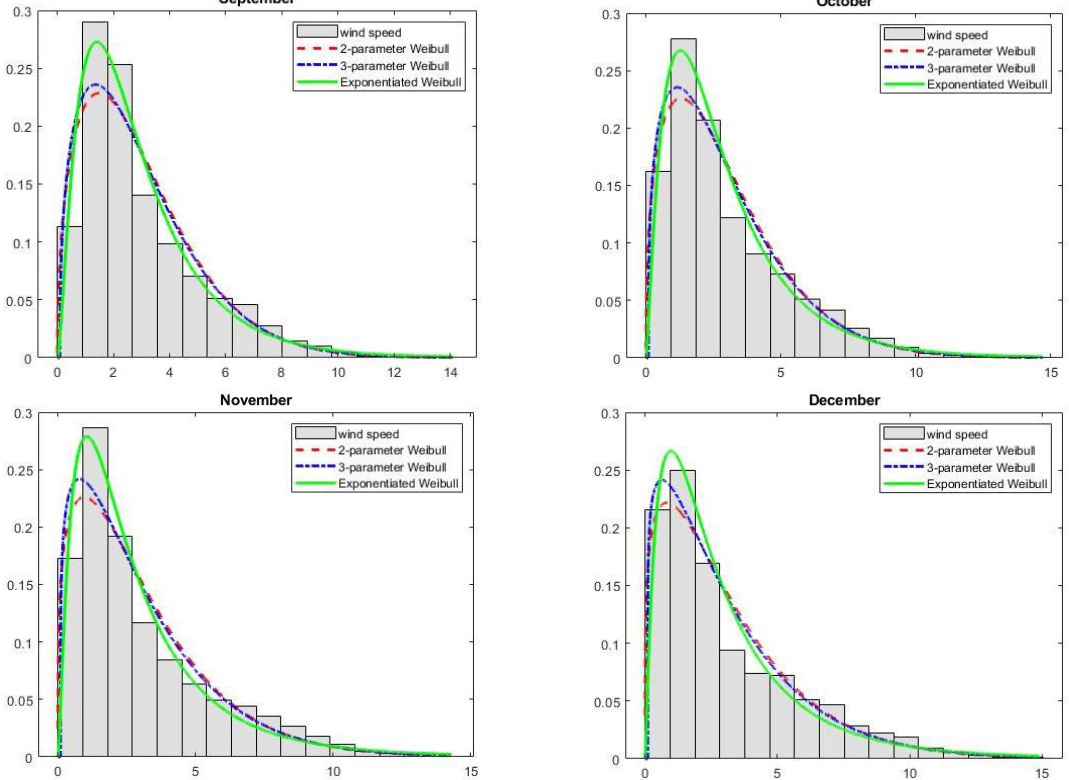
Figure 7. Modelled probability distributions fitted to the histogram of the wind speed data — the respective months.